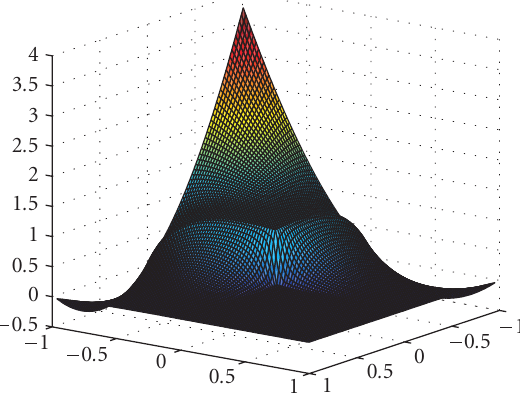
Figure 4.11 . Example 4.3: surface plot of discrete solution on a 64 × 64 mesh. Solution is exhibiting a singularity at